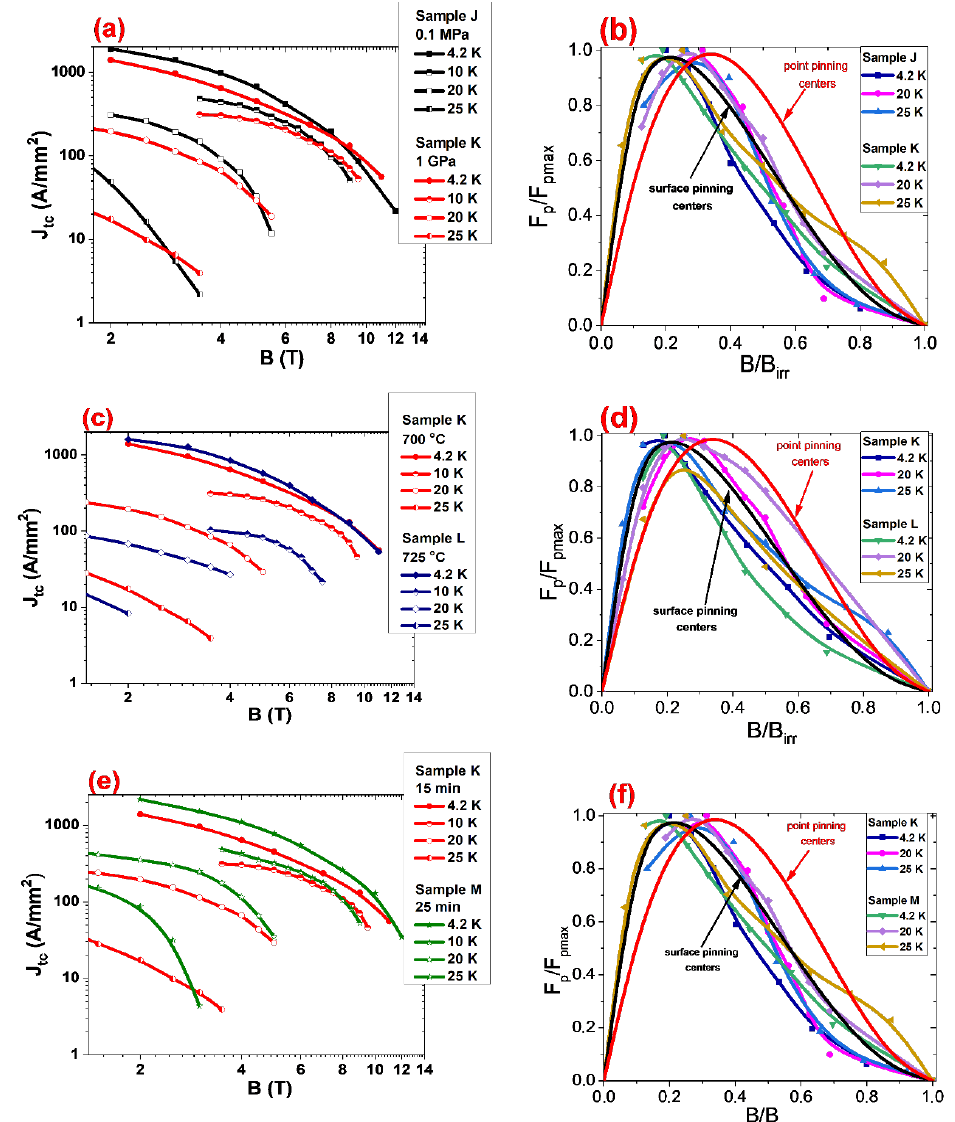
Figure 8. ( a , c , e ) The transport critical current density ( J tc ) as a function of the perpendicular magnetic field ( B ) at 4.2 K, 10 K, and 20 K for SiC doped MgB 2 wires with a 0.63 mm diameter. ( b , d , f ) The reduced pinning force depending on the reduced magnetic fields for SiC doped MgB 2 wires.